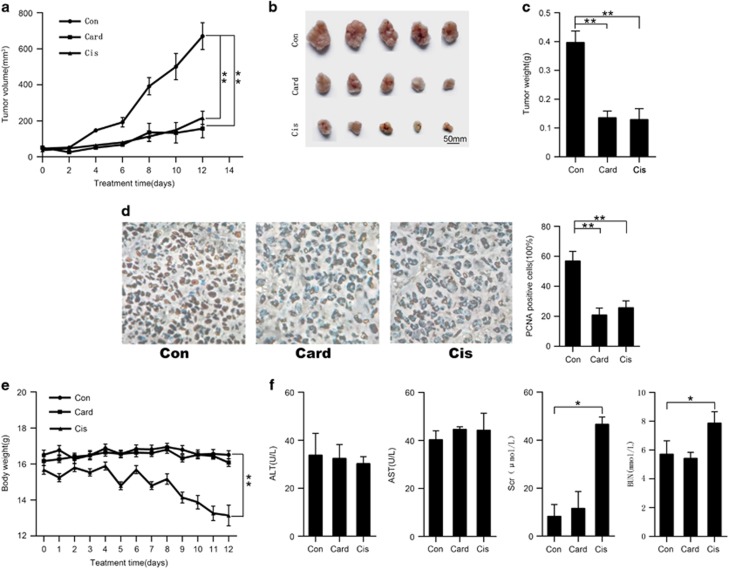
Cardamonin inhibits tumor growth in vivo without serious side effects. (a) Tumor volume was measured every other day and plotted. (b) Tumors for each group were photographed. (c) Tumor weight was measured after being killed. (d) Tumors were stained with PCNA and analyzed using histochemistry. (e) Body weights of each group were measured every day. (f) ALT, AST, BUN, Scr in serum were evaluated for each group. *P<0.05, **P<0.01, n=5